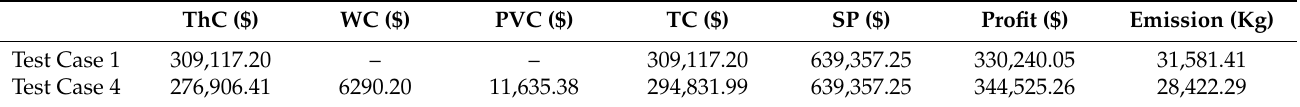
Figure 10. Optimal generation schedule under the scenario of Cost minimization (Test Case 4). Table 4. Cost, Selling price, Profit and Emission under the scenario of profit